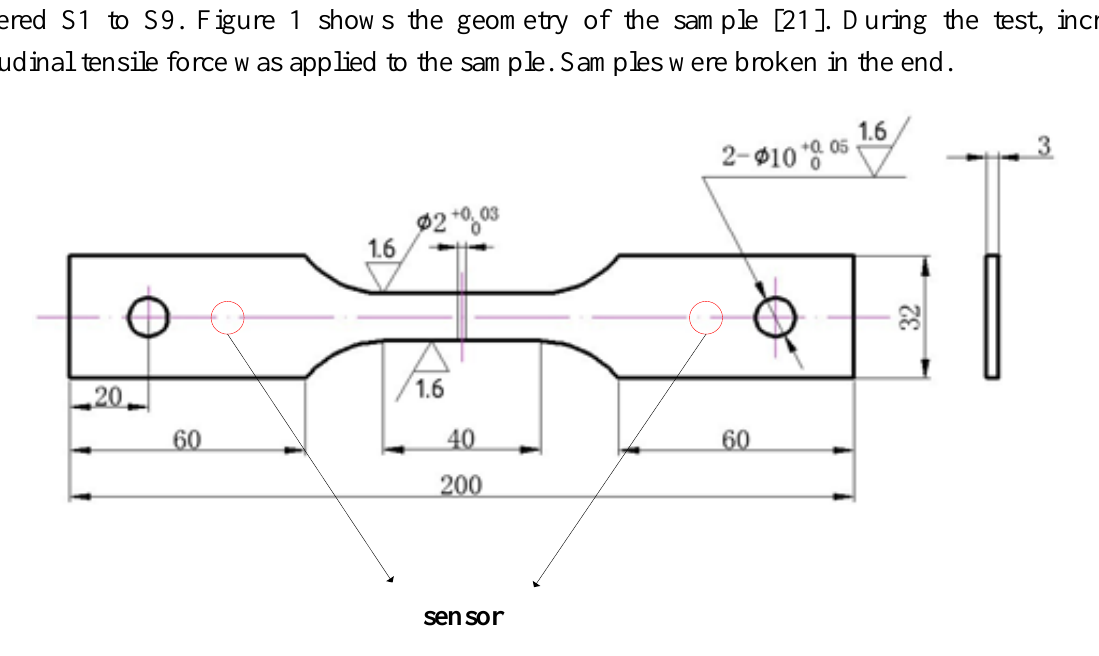
Figure 1. Geometry of tensile sample and arrangement of AE sensors, dimensions in mm [21].